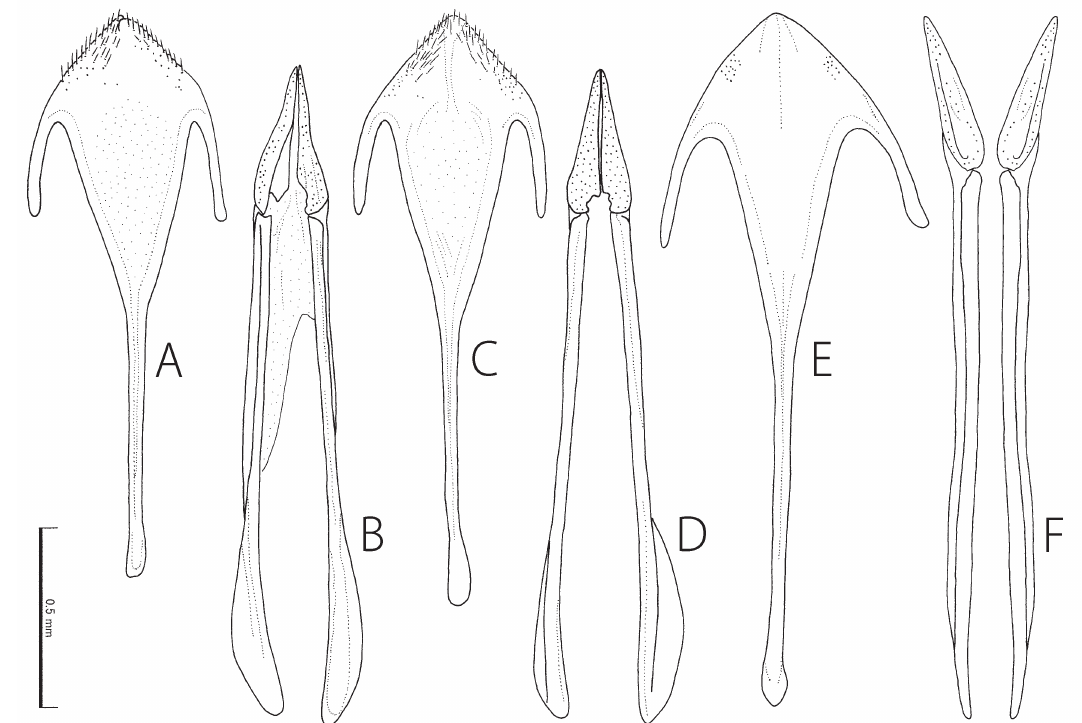
Fig. 4. Female genitalia of Caccothryptus spp. A – B . Caccothryptus taiwanus sp. nov. C – D . C . orion sp. nov. E – F . C . tibetanus sp. nov. — A , C , E . Spiculum ventrale. B , D , F .